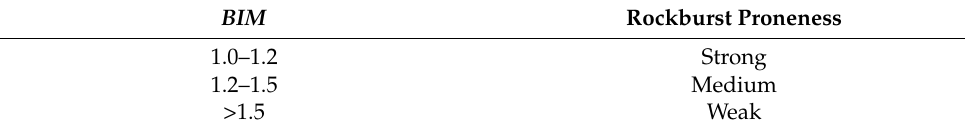
Figure 2. Calculation diagram of BIM and F based on uniaxial compression test. Table 3. Evaluation criteria of rockburst proneness based on BIM.